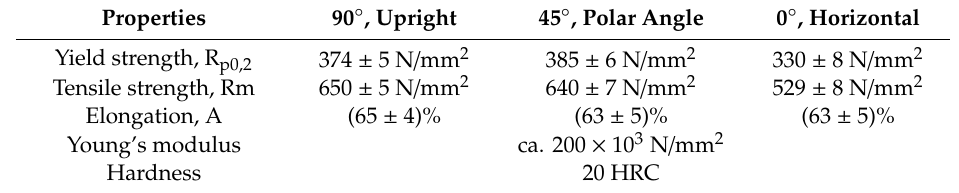
Table 2. Mechanical properties of steel 316L.